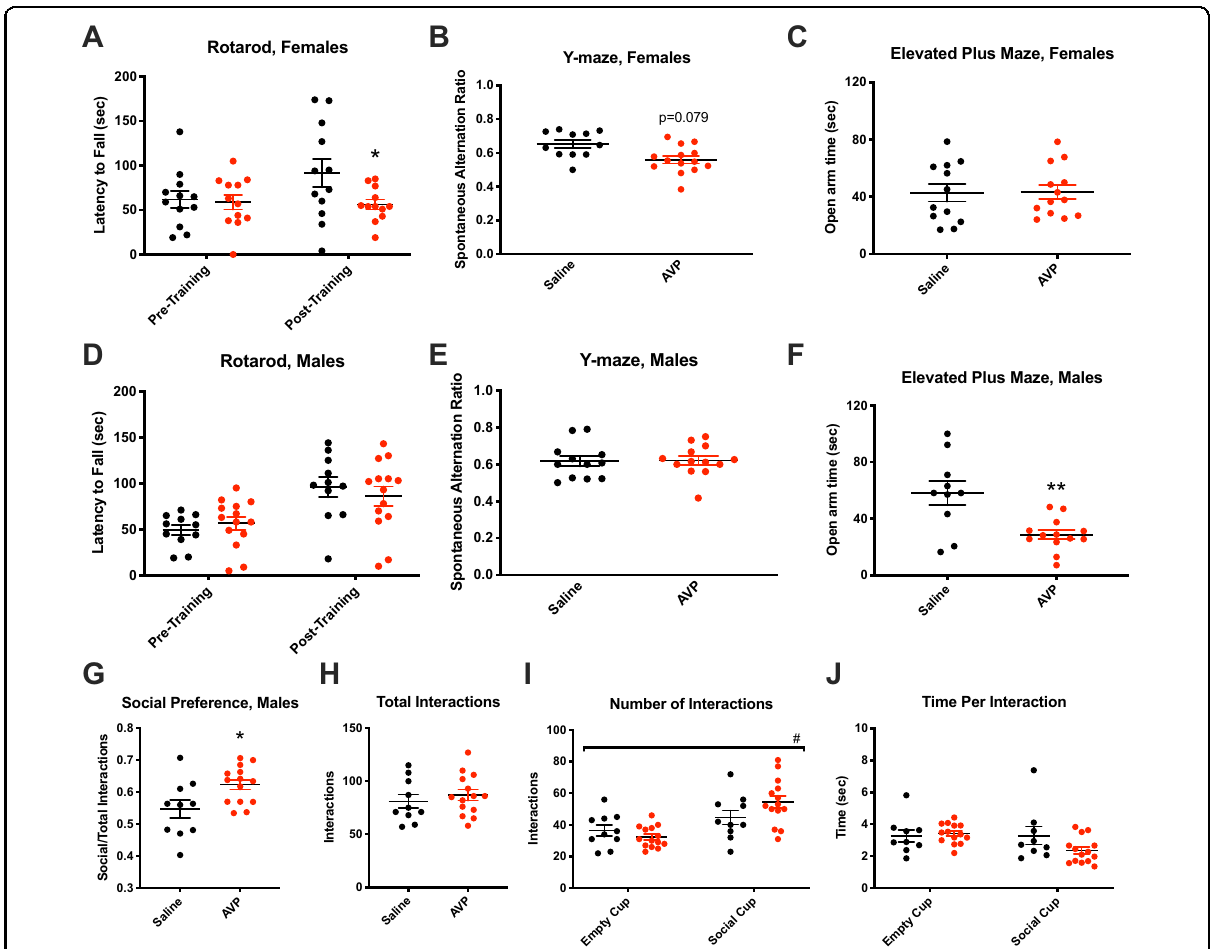
Fig. 1 Adult offspring behavior was sex-speci fi cally changed by prenatal maternal AVP. a AVP-exposed adult females exhibited decreased post-training performance on the rotarod procedural learning task ( p = 0.048), while ( d ) male rotarod learning was unchanged by AVP status. b Trend-signi fi cant working memory de fi cits, as measured by spontaneous alternations on the Y-maze, also occurred in AVP-exposed female ( p = 0.079), but not male ( e ), offspring. c While AVP-exposed female did not exhibit anxiety-like behavior changes, f AVP-exposed male offspring spent signi fi cantly decreased time on the open arm of the elevated plus maze ( p = 0.0019). g Social preference was signi fi cantly ( p = 0.018) increased in AVP-exposed male offspring, while ( h ) total interactions were unchanged. i Offspring from both conditions had signi fi cantly more interactions with the social cup than with the empty cup [main effect of cup type by two-way ANOVA p < 0.0001, F 1,44 = 19.31], while ( j ) time spent at each cup did not differ by condition. # p < 0.0001 by two-way ANOVA, * p < 0.05, ** p < 0.005 per two-sample t -test, error bars represent SEM. 4 litters per condition, 1 – 6 offspring per sex per